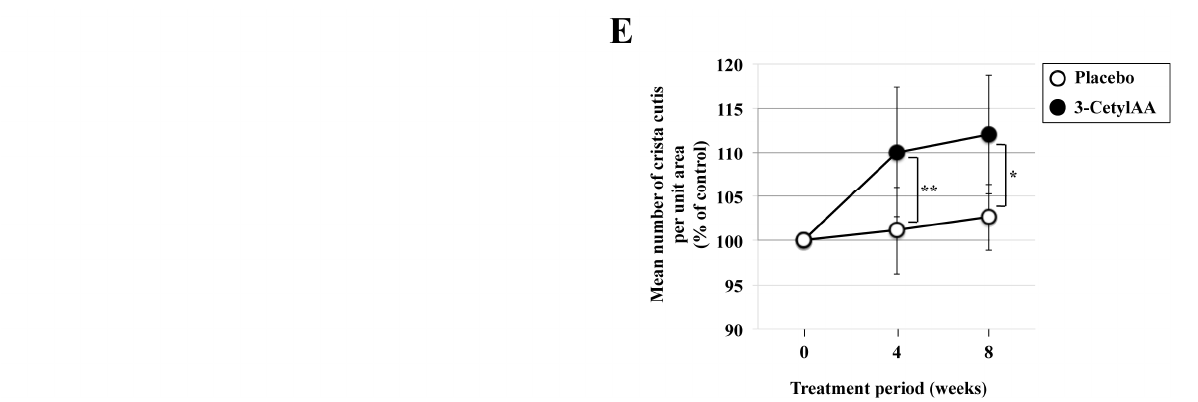
Figure 3. Improvements in the texture of sun-exposed skin after treatment with 3-CetylAA: ( A ) Study design and treatment schedule. A cream containing 25 mM 3-CetylAA and a placebo cream were topically applied to the sun-exposed facial skin of 14 and 13 healthy volunteers, respectively. All volunteers underwent twice-daily treatments for 4 and 8 weeks. The skin texture was analyzed before and 4 and 8 weeks after the treatment. ( B ) Typical reflective replica images from skin treated with either 3-CetylAA or placebo. The images were obtained using the 3D Skin Roughness Analysis Measurement System. Scale bar, 1000 µ m. ( C ) Effects of 3-CetylAA on the distance between sulci cutis. The data were obtained from three different areas (20 mm × 20 mm) in each volunteer. Values indicate means ± S.D. * Significant difference ( p < 0.03). ** Significant difference ( p < 0.01). ( D ) Effects of 3-CetylAA on coefficient of variation between sulci cutis in the above data. Values indicate means ± S.D. * Significant difference ( p < 0.02). ** Significant difference ( p < 0.007). ( E ) Effects of 3-CetylAA on number of crista cutis per unit area. The data were obtained from three different areas (20 mm × 20 mm) in each volunteer. Values indicate means ± S.D. * Significant difference ( p < 0.002). ** Significant difference ( p < 0.0008).